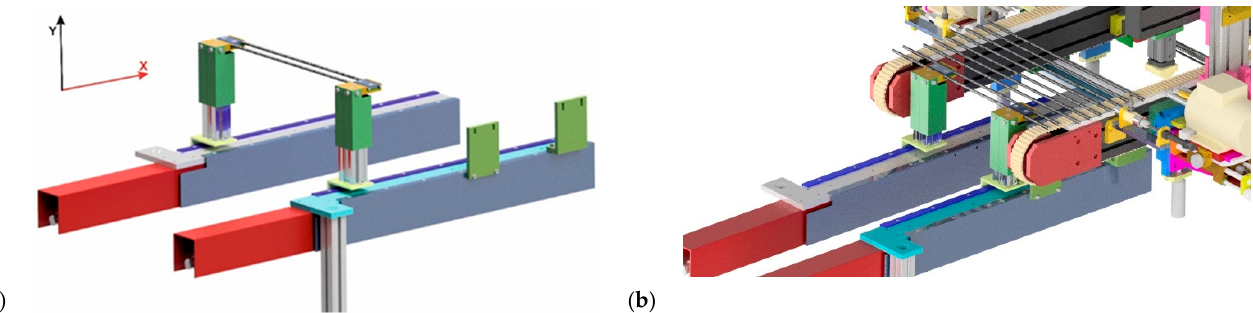
Figure 17. Schematic of the manipulator ( a ) and assembled manipulator and spiral transfer system ( b ).